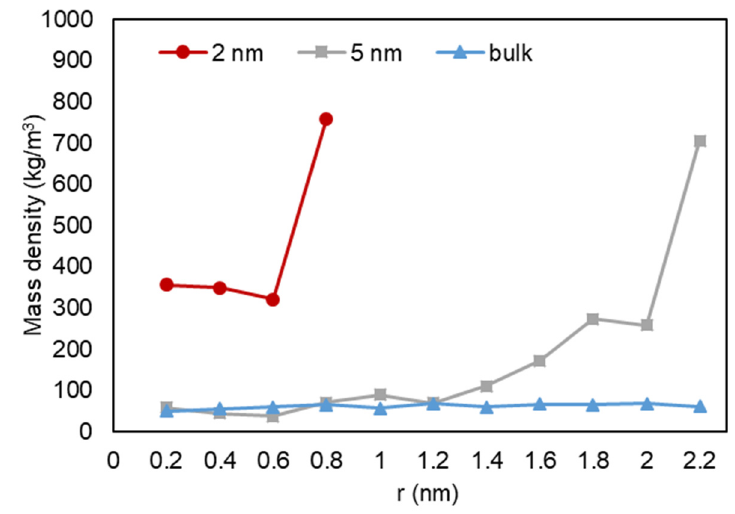
Figure 18. Mass density variation vs. radial position for C1.